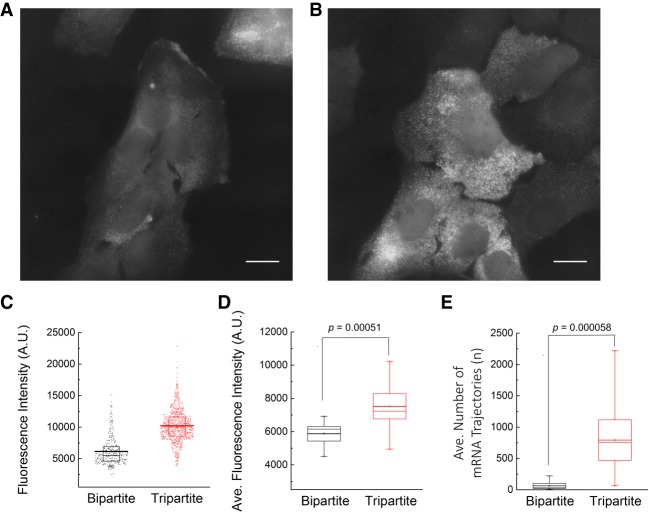
Comparison of the bipartite and tripartite sfGFP systems for single-mRNA imaging. (A) Fluorescence image of U2OS cells expressing the reporter mRNA labeled with the bipartite sfGFP system. (B) Fluorescence image of U2OS cells expressing the reporter mRNA labeled with the tripartite sfGFP system. Scale bars, 20 µm. (C) Fluorescence intensity of single mRNAs detected from a cell transfected with the bipartite (black) or tripartite (red) sfGFP system. Each dot represents the fluorescence intensity of an individual mRNA. The mean value is marked with a horizontal line. (D) The average fluorescence intensity of mRNAs labeled with each split sfGFP system (n = 17 cells for each system). (E) The average number of mRNA trajectories detected by each system (n = 17 cells for each system). The mean values are marked with open squares with thick, horizontal lines. The boxplots show the median (horizontal line in the box), first and third quartile (lower and upper hinges of the box, respectively), with whiskers from the minimum to maximum values. The P-values were determined by Student's t-test.